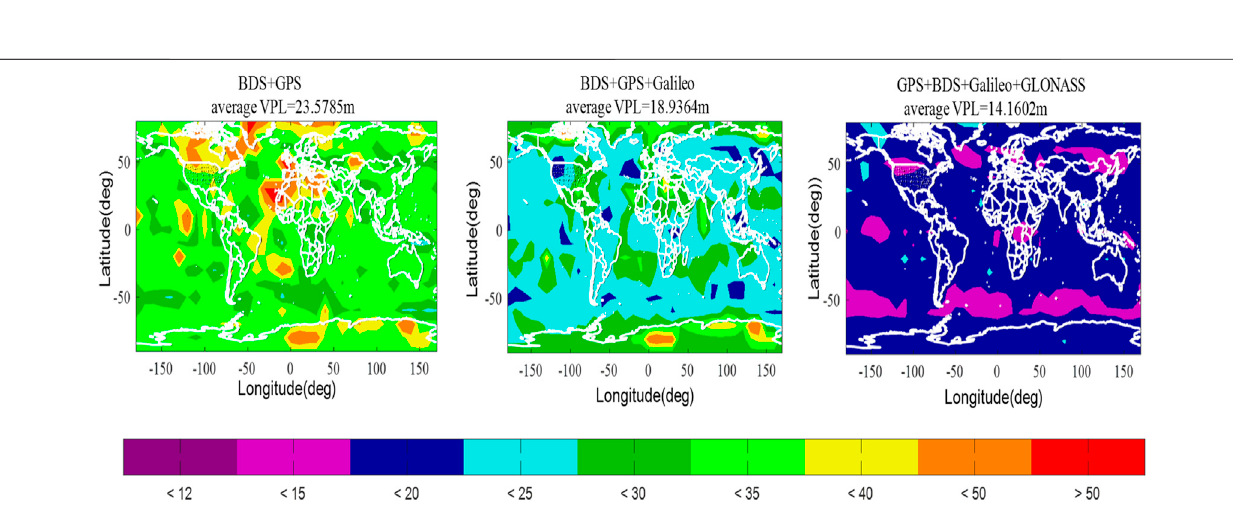
FIGURE 4 | VPL under different constellation numbers before optimization.